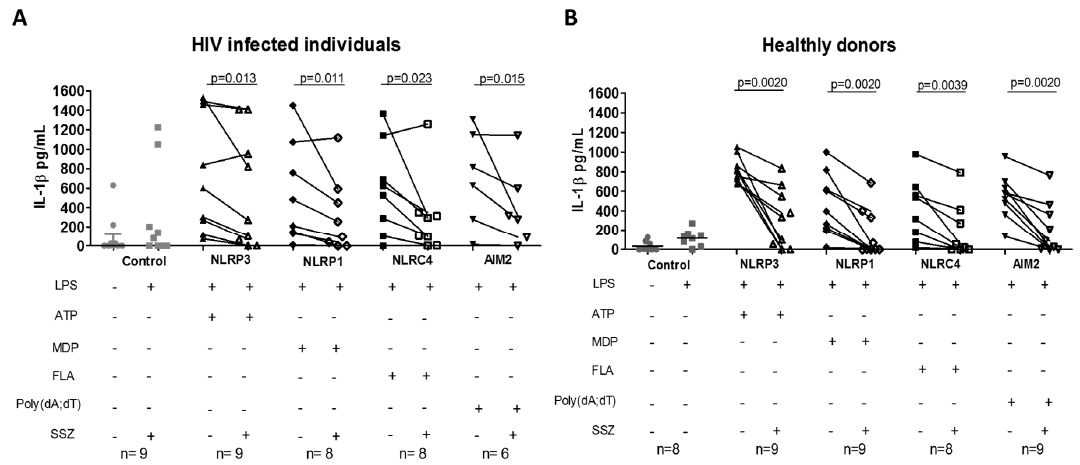
Figure 1. The release of IL-1 β by peripheral blood mononuclear cells (PBMCs) in response to inflammasome agonists and sulfasalazine (SSZ) . The production of IL-1 β by PBMCs from healthy donors ( A ) and people living with HIV ( B ), which were treated with inflammasome agonist in vitro (ATP 2 mM for NLRP3; Flagellin 500 ng / mL for NLRC4; poly(dA;dT) 50 µ g / mL for AIM2; and MDP 0.1 µ g / mL for NLRP1) in the presence of 1 mM SSZ during 4 h of incubation or 2 h for ATP-treated cells, was quantified by ELISA. Statistical comparison between groups was performed using a Wilcoxon matched-pairs signed rank one-tailed test with a confidence level of 95%. ( + : presence, − : absence).